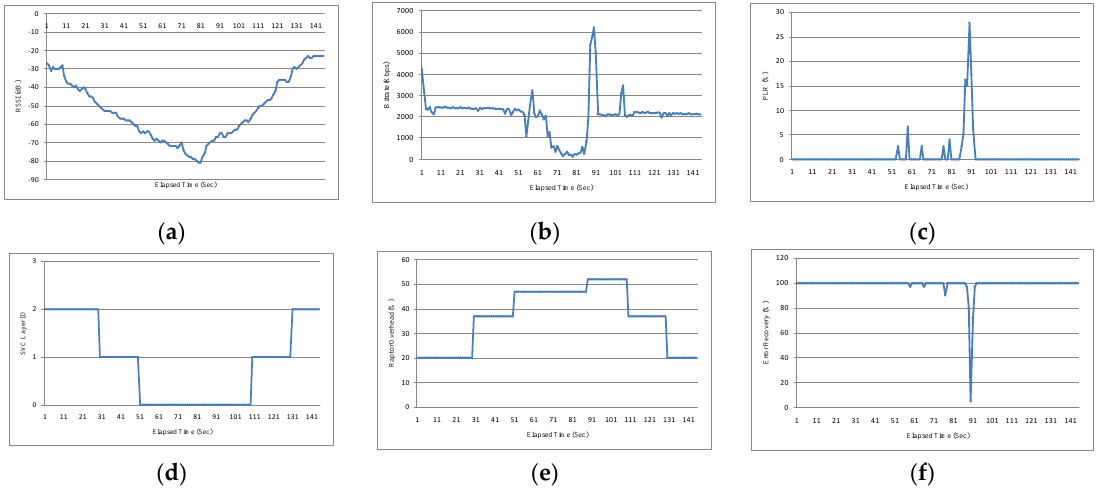
Figure 12. Reactions and adaptations of the proposed system according to the measured link quality in real moving experimentation. ( a ) RSSI changes; ( b ) ABW changes; ( c ) PLR changes; ( d ) SVC layer switching; ( e ) Raptor overhead adaptation; ( f ) Packet loss recovery.